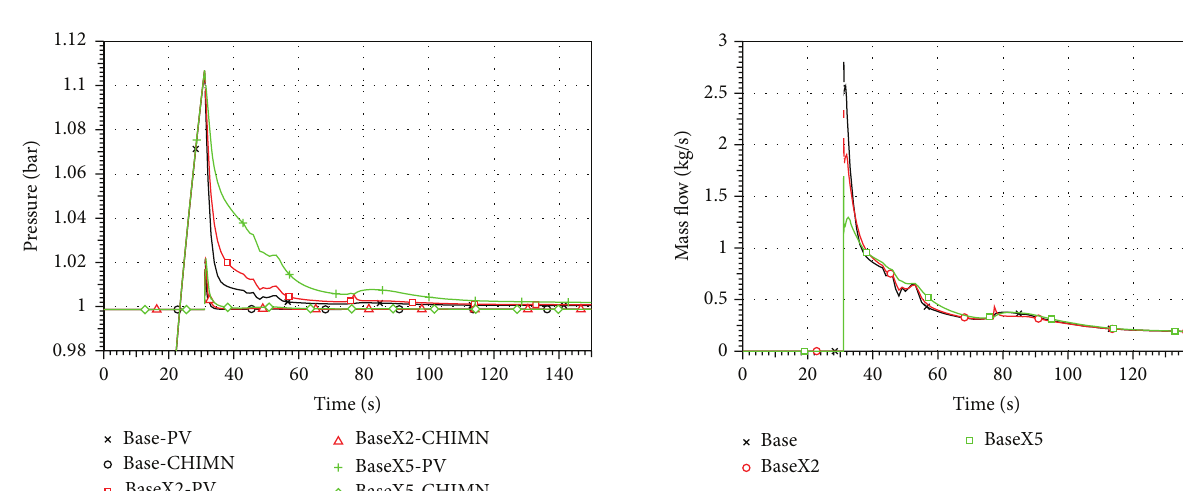
Figure 18: Pressure losses: comparison of flow rates through the burst disk.